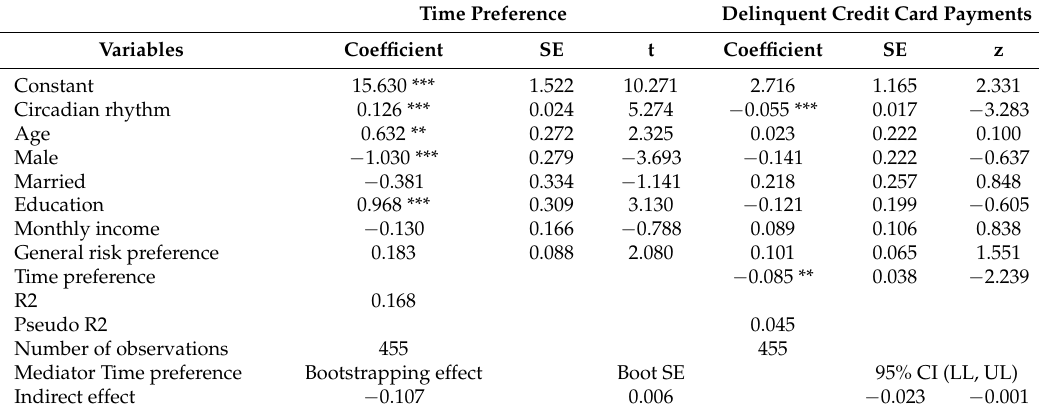
Table A2. The mediating effect of time preference on the relationship between circadian rhythm and delinquent credit card